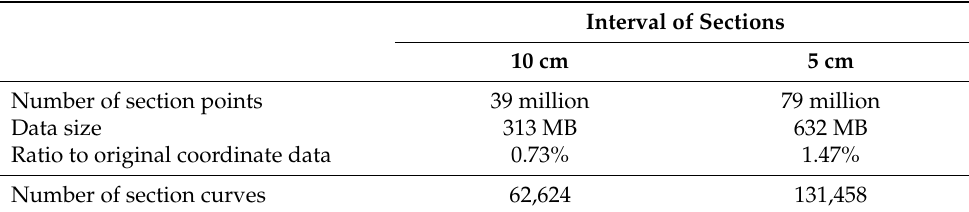
Table 5. Timing for stem detection from Dataset A using 10-cm